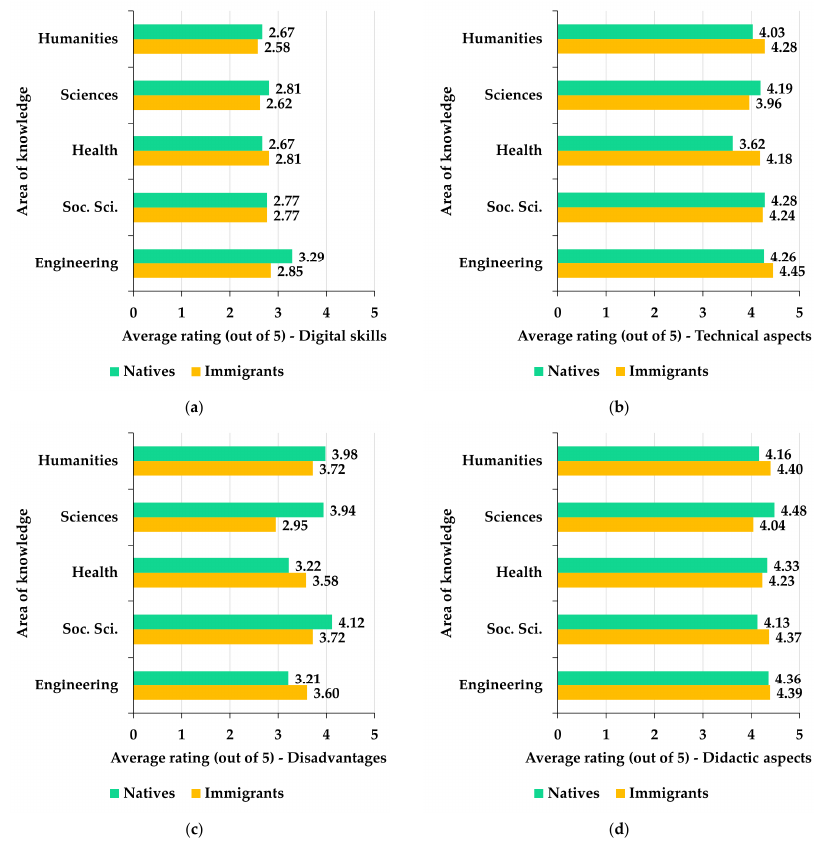
Figure 7. Average ratings, differentiated by areas of knowledge and digital generation, of the dif- ferent families of questions: ( a ) digital skills; ( b ) technical characteristics of VR; ( c ) disadvantages of VR; and ( d ) didactic usefulness of VR.